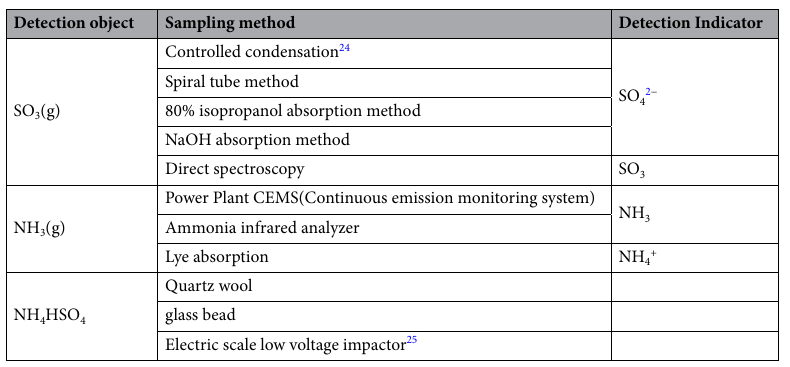
Table 2. Collection methods.